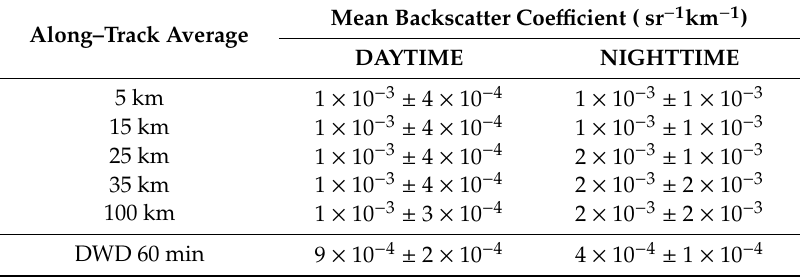
Table A7. Mean backscatter coe ffi cient values with the respective standard deviation for all CALIOP along–track averages and Harzgerode 60 min average profile for 14 daytime and 26 nighttime